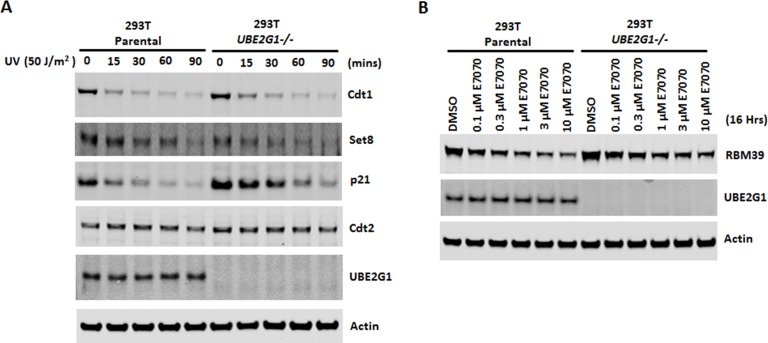
Depletion of UBE2G1 attenuated the degradation of p21 and RMB39 induced by UV irradiation and sulfonamide treatment, respectively.(A and B) Immunoblot analysis of 293T parental and UBE2G1-/- (clone 13) cells treated with UV irradiation (A) or E7070 (B). In (A), cells were UV irradiated at 50 J/m2 using a Stratalinker, and collected at the indicated time points thereafter. In (B), cells were treated with DMSO or an increasing concentration of E7070 for 16 hr. All results shown in this figure are representative of three independent experiments.